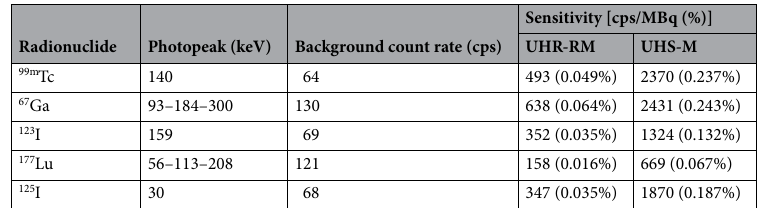
Radionuclide Photopeak (keV) Background count rate